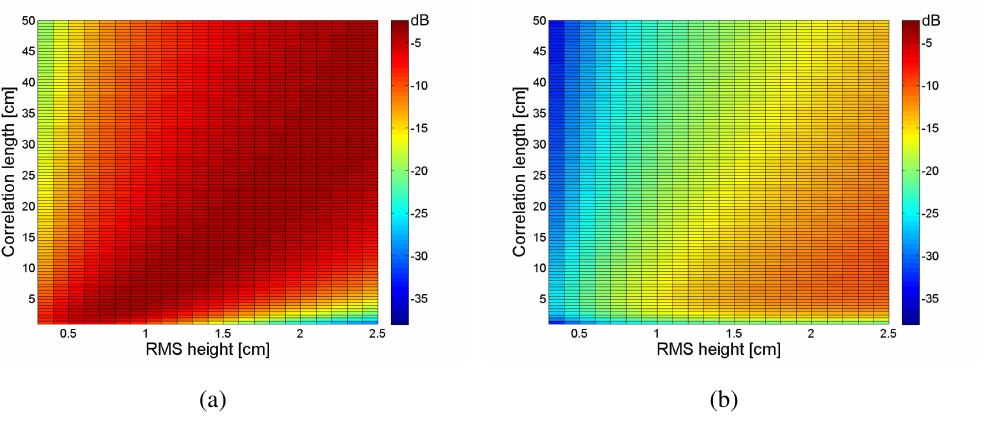
Figure 1. Backscatter coefficients calculated for different values of RMS height and corre- lation length and a moisture content of 25 vol% for (a) an ASAR VV configuration and (b) a PALSAR HH